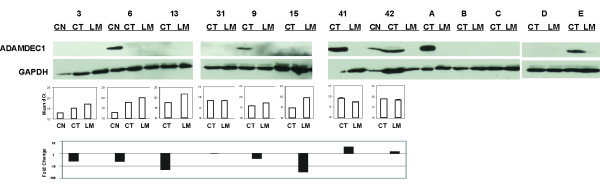
Western analysis of ADAMDEC1. Analysis of matched CN (colon normal), CT (colon tumour) and LM (liver metastasis) for 13 patients is shown. GAPDH was used as a loading control. Numbers refer to patients IDs and allow cross-referencing to LOH and gene expression data where appropriate. Letters correspond to additional samples for whom mRNA expression and LOH was not undertaken. Where available mRNA expression is shown as mean dCt (Y-axis) underneath the corresponding sample and Fold Change for LM relative to CT is presented.